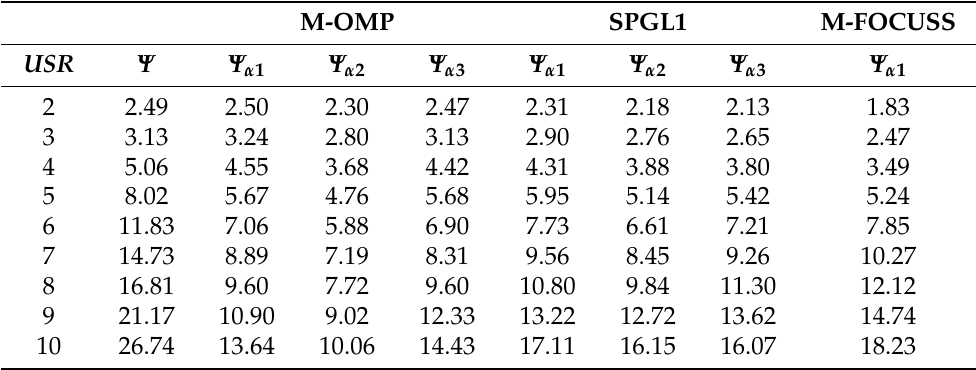
Table 10. Comparison of PRD values from the algorithms using the three dictionary matrices at several USR values, for ECG signal No.